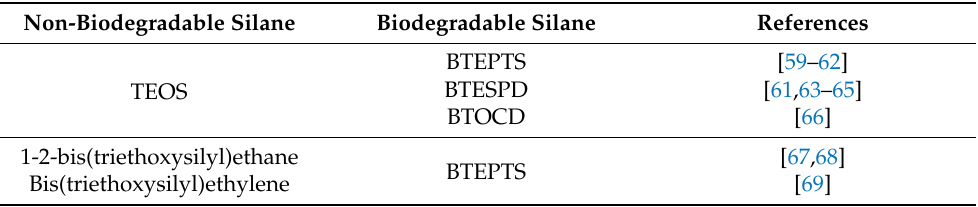
Table 2. Summary of the biodegradable and non-biodegradable organosilanes employed for the synthesis of bridged NPs.